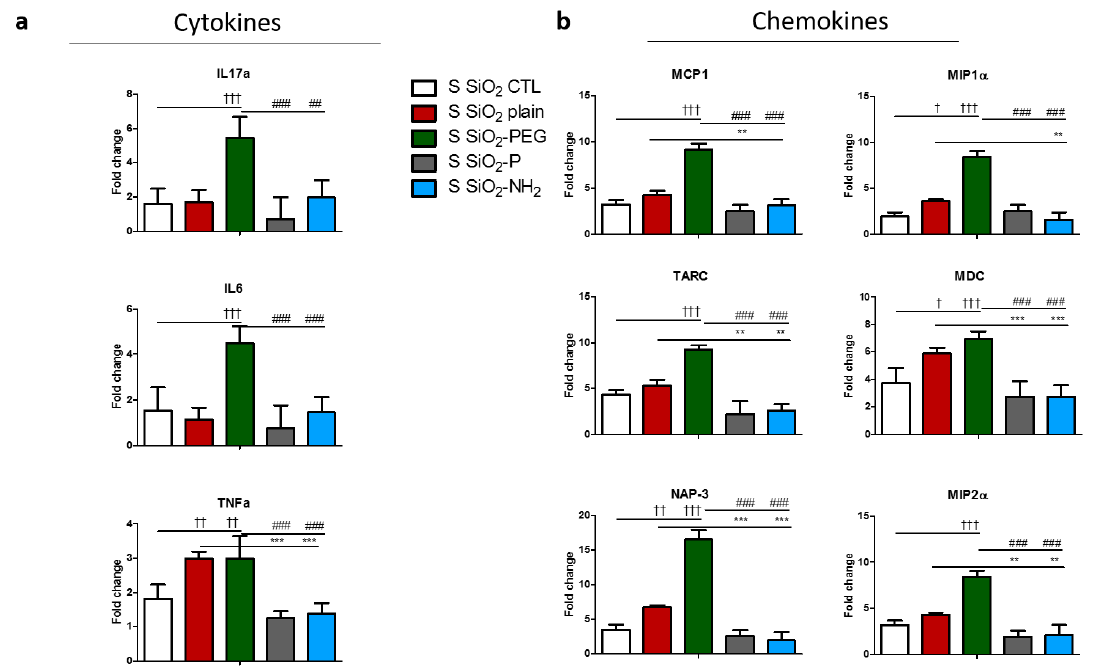
Figure 6. Specific surface modifications of silica nanoparticles diminish selective inflammatory genes expression in S mice in vivo . Representative gene regulations of ( a ) cytokines or ( b ) chemokines in mice lungs 5 days after intratracheal instillation of 50 µ g SiO 2 plain (red), SiO 2 -PEG (green), SiO 2 -P (gray) or SiO 2 -NH 2 blue) or supernatant control (CTL), and ovalbumin challenge. Mean ± standard deviation were evaluated in lung by real-time PCR ( n = 4/group). One-way Anova † p < 0.05; †† p ≤ 0.01; ††† p ≤ 0.01 vs. CTL p ≤ 0.001; * p < 0.05; ** p ≤ 0.01; *** p ≤ 0.001 vs. SiO 2 plain. # p < 0.05; ## p ≤ 0.01;